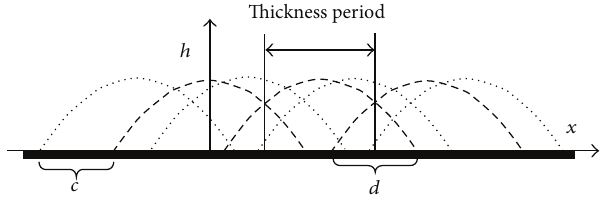
Figure 11: Painting when 0.5𝑑 < 𝑐 ≤ 𝑑 , 𝑐 + 𝑑 > 0.5 , 𝑐 + 2𝑑 > 1 and 𝑐 + 1.5𝑑 > 1